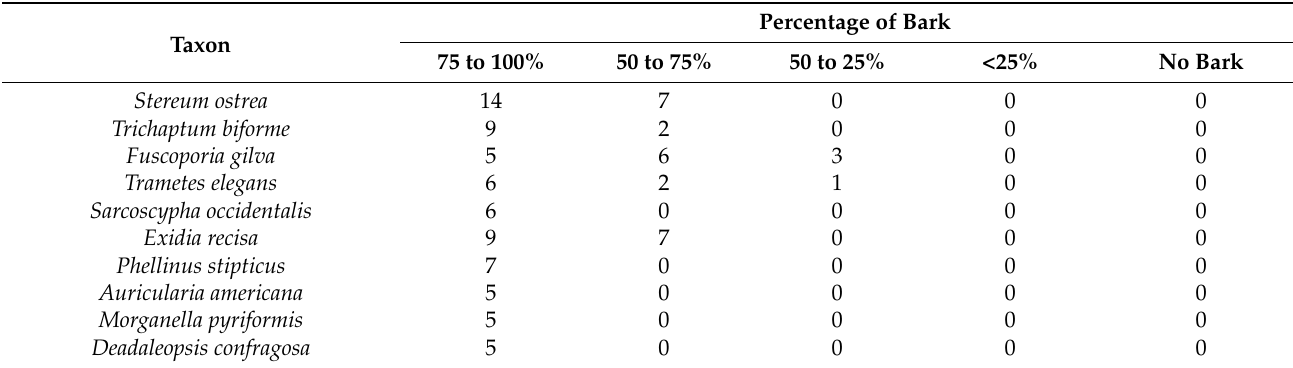
Table 3. Distribution of species of wood-decay fungi in relation to the stage of decay of the woody substrates from which they were collected.